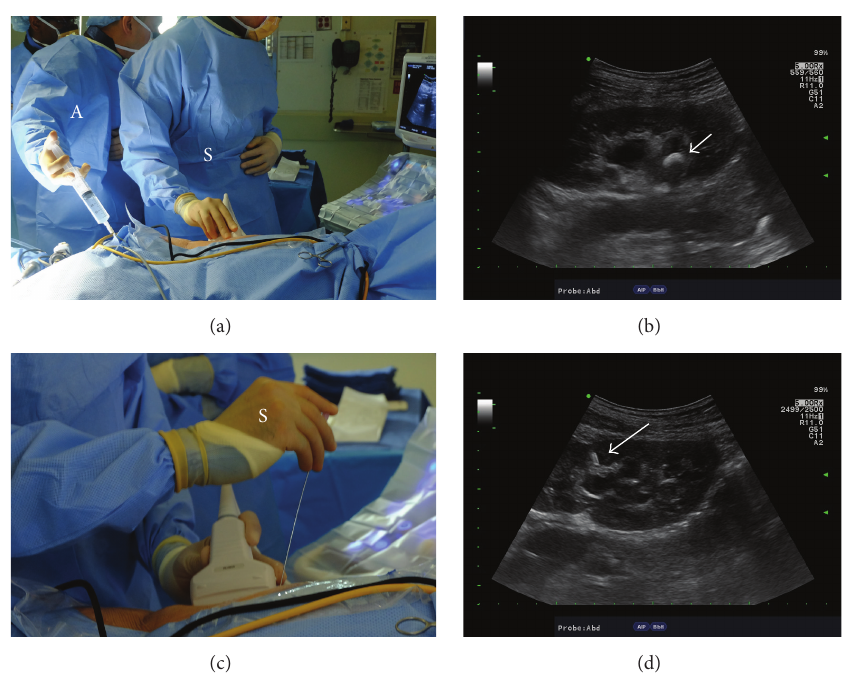
Figure 1: Establishing renal access using ultrasound guidance. (a) The operative surgeon (S) holds the ultrasound probe and the assistant (A) holds a syringe attached to ureteral catheter for normal saline infusion if needed. (b) Ultrasonographic image of the kidney along its longitudinal axis demonstrating the stone in the renal pelvis (white arrow) within a mildly hydronephrotic collecting system. (c) During the needle insertion, the operative surgeon (S) holds both the ultrasound probe and the needle to perform the puncture. For hand positioning, the nondominant hand holds the ultrasound probe while the dominant hand holds the needle. (d) The needle can be visualized (white arrow) entering the collecting system through upper pole calyx in this